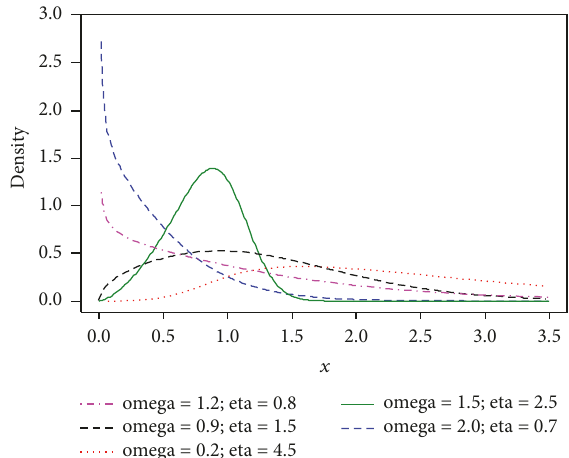
Figure 1: The shapes of the PDF of the HLGW